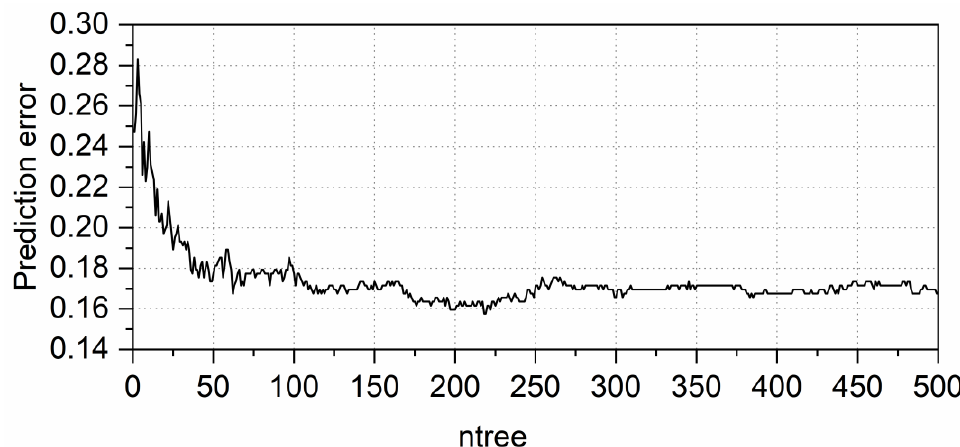
Figure 7. Prediction error of Random Forest model with different mtry.